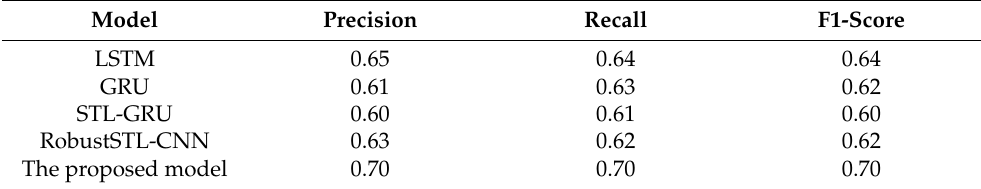
Table 2. Precision, recall, and F1-score of the proposed model and counterpart models.